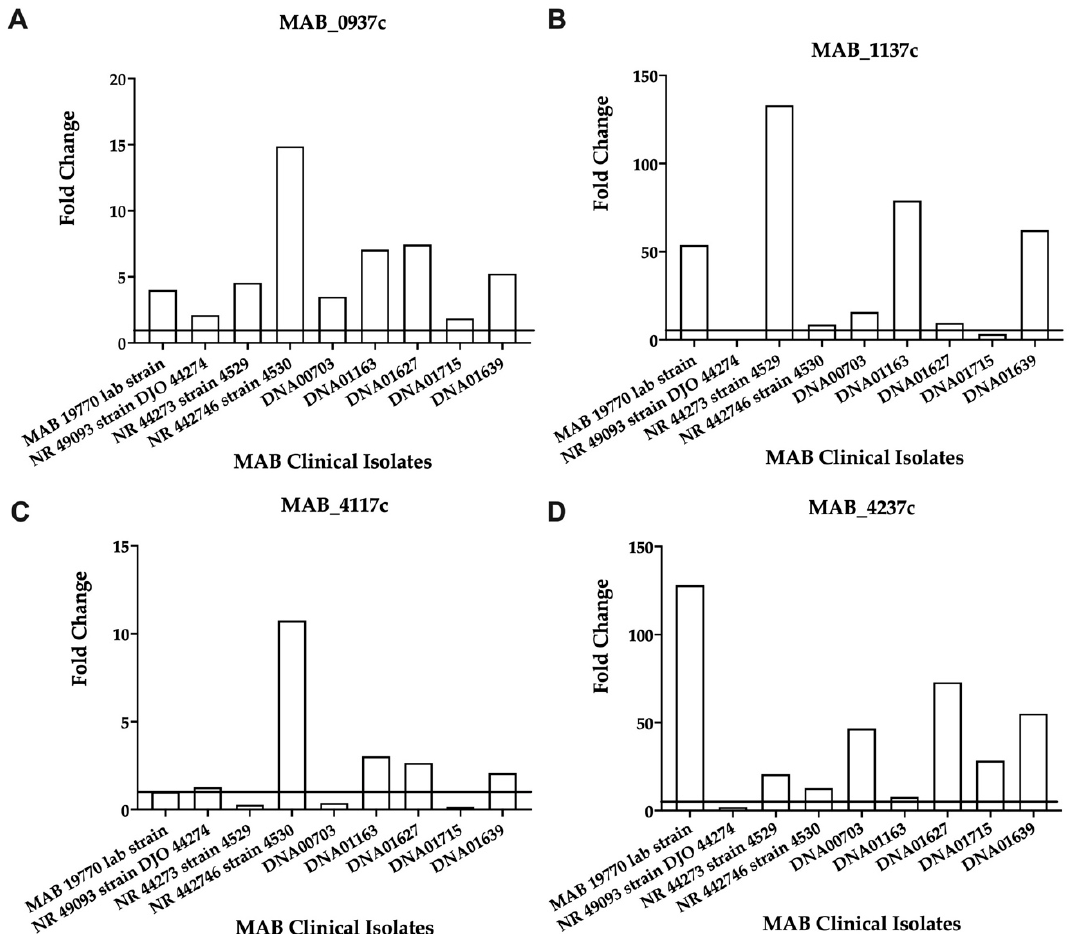
Figure 4. The fold changes in the efflux pump and ABC transporter gene expressions in the clinical isolates of MAB exposed to AMK. Each clinical strain at 3 × 10 8 CFU/mL was matched to the McFarland Standard 1.0 and inoculated with 1 × MIC of AMK. The RNAs were extracted after 8 h, and the DNase was treated and used for cDNA synthesis, as described in the Materials and Methods. The gene expressions were evaluated with qRT-PCR. ( A ) MAB_0937c , MmpL drug efflux pump; ( B ) MAB_1137c , MmpL efflux pump; ( C ) MAB_4117c , efflux pump related MmpS; ( D ) MAB_4237c encodes for an ABC transporter.